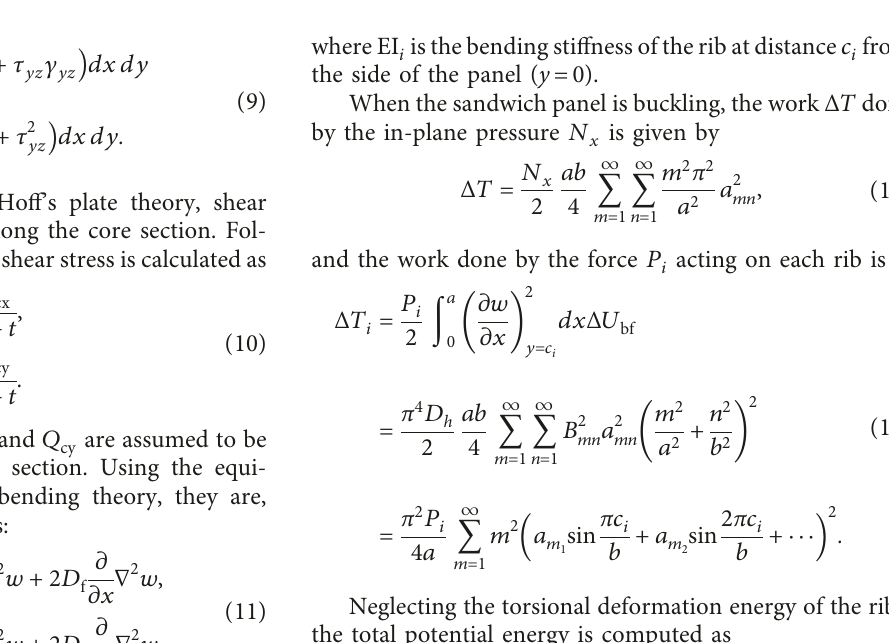
Figure 3: Section of sandwich plate and SPS with stiffeners. (a) Structure sketch of SPS reinforced by cross wall. (b) Simplified loading schematic